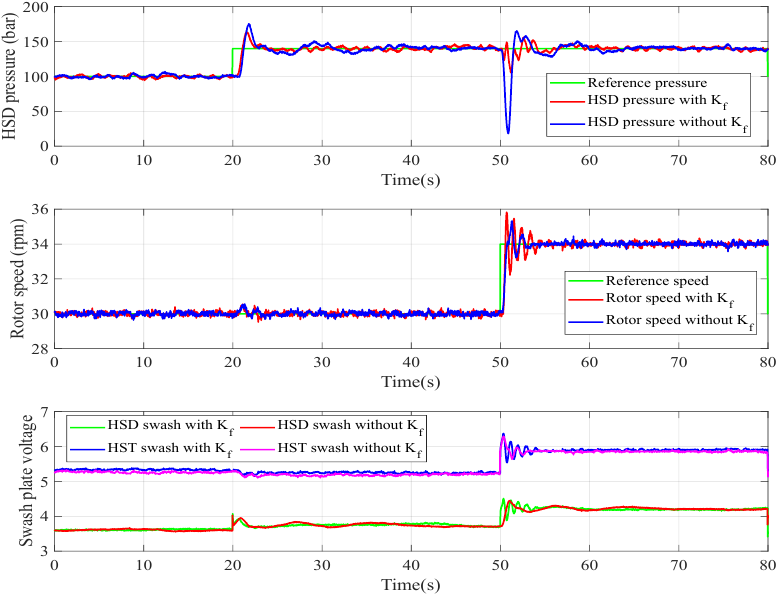
Figure 13. Pressure and rotor speed in response to the step